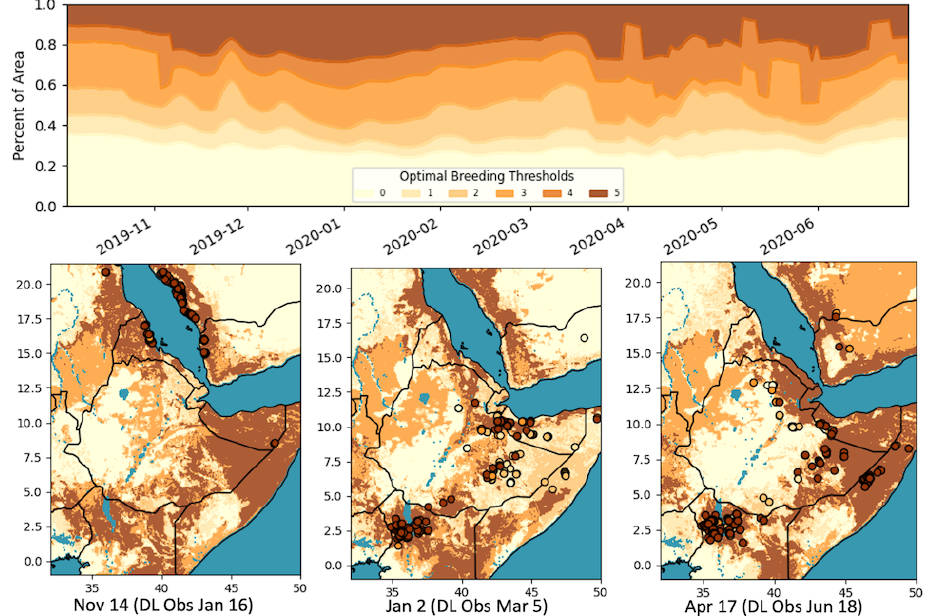
Figure 2. Optimal DL breeding threshold maps and the percentages of areas under each classification over time. Breeding thresholds: 0: no conditions met, 1: sand or clay threshold met, 2: sand and clay met, 3: only soil moisture (SM) threshold met, 4: one soil type and SM met, 5: all conditions